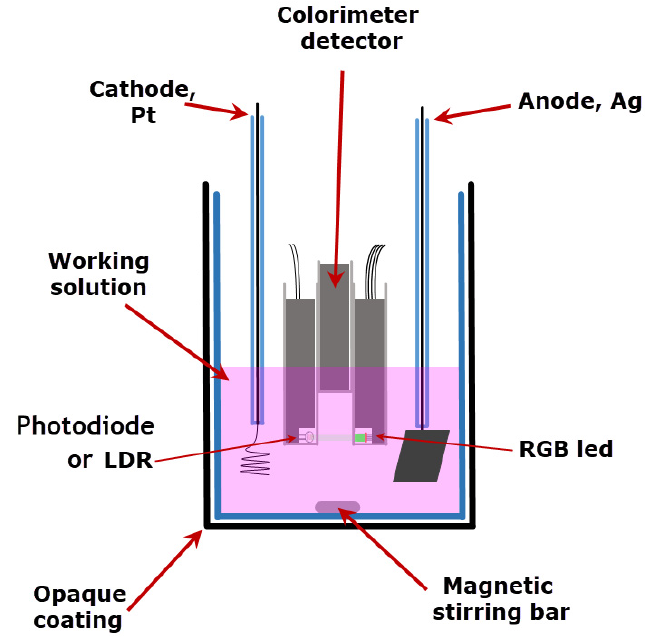
Figure 6. Schematics for a single-compartment coulometric cell employed for acid/base titrations.